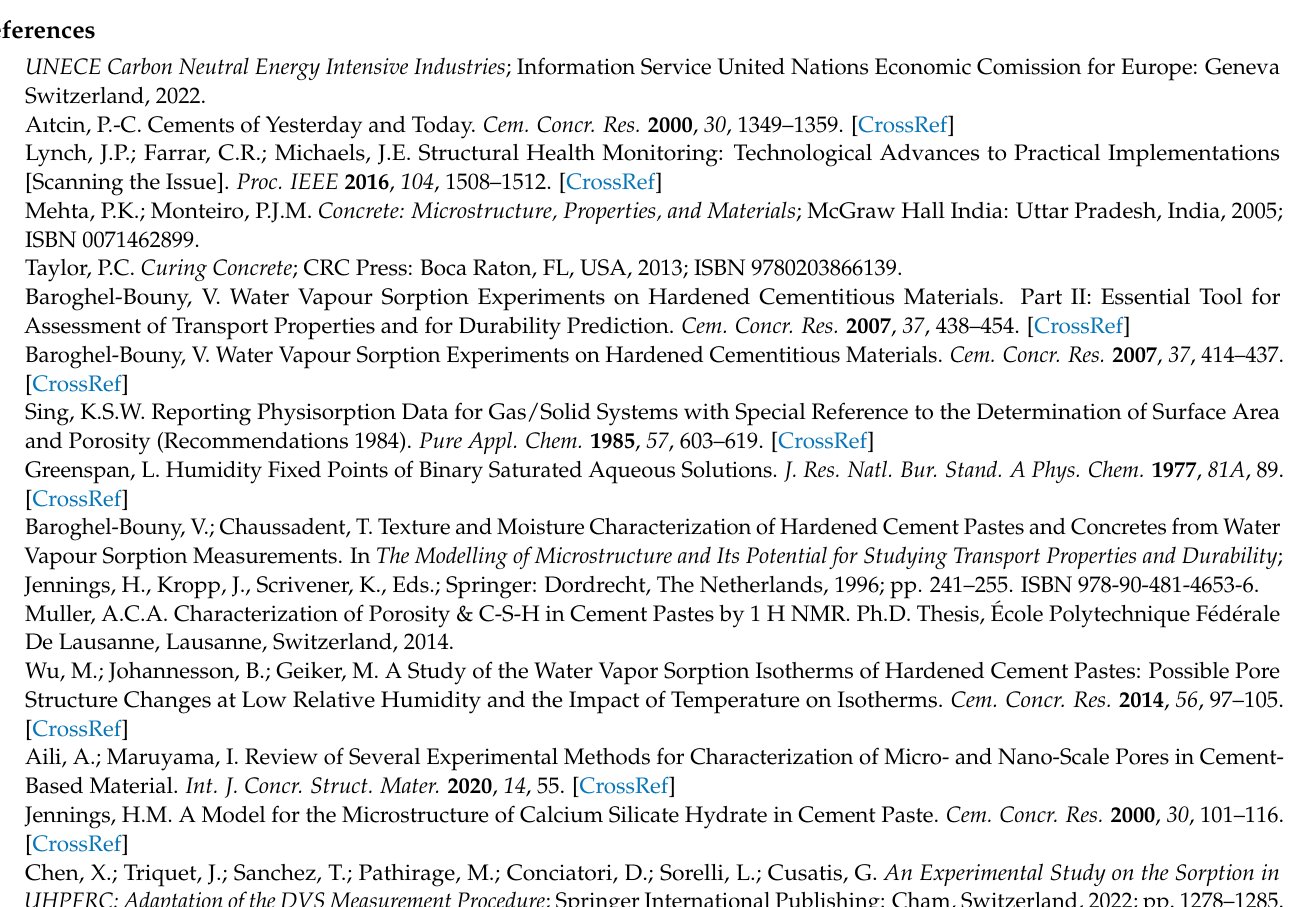
Figure A2. ( a ) Raw reflected light intensities for different RH between 8.9 and 97.6% and ( b ) the chosen stable points for analysis. Results were achieved by integrating intensities between 388 and 400 nm.